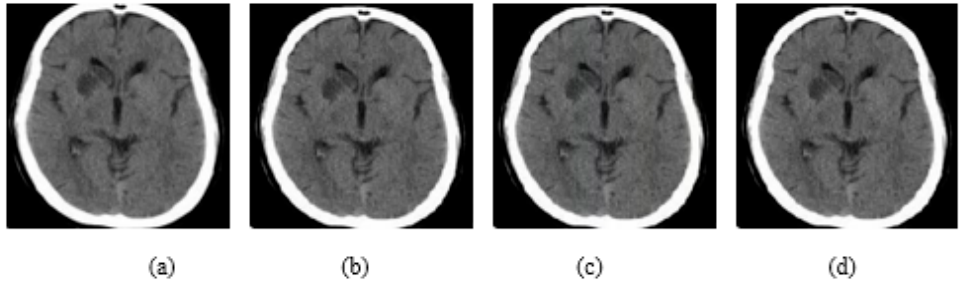
Figure 6. ( a ) Initial Image, ( b ) FGSM attack with ϵ = 0.01, ( c ) PGD attack with ϵ = 0.01, ( d ) Square Attack with ϵ = 0.01 .